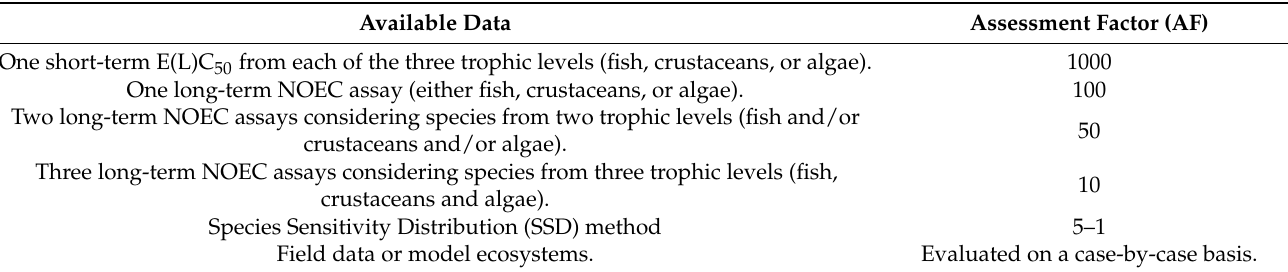
Table 7. Assessment factors used for PNECs derivation [145]. Available Data